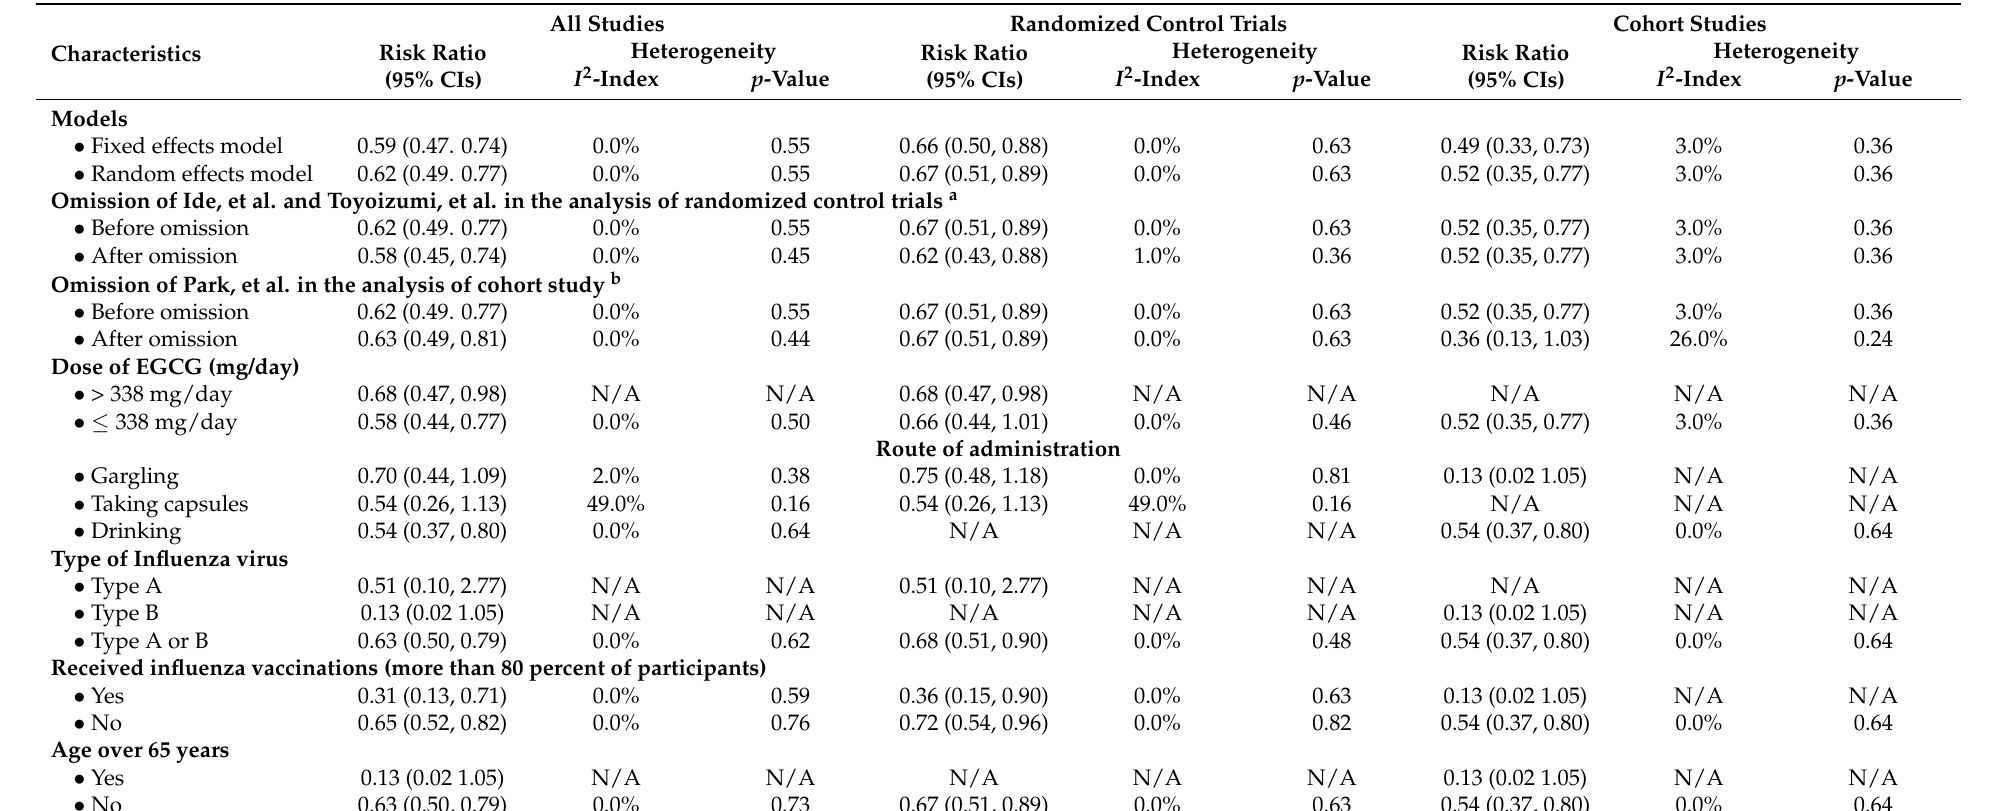
Table 3. Sensitivity and subgroup